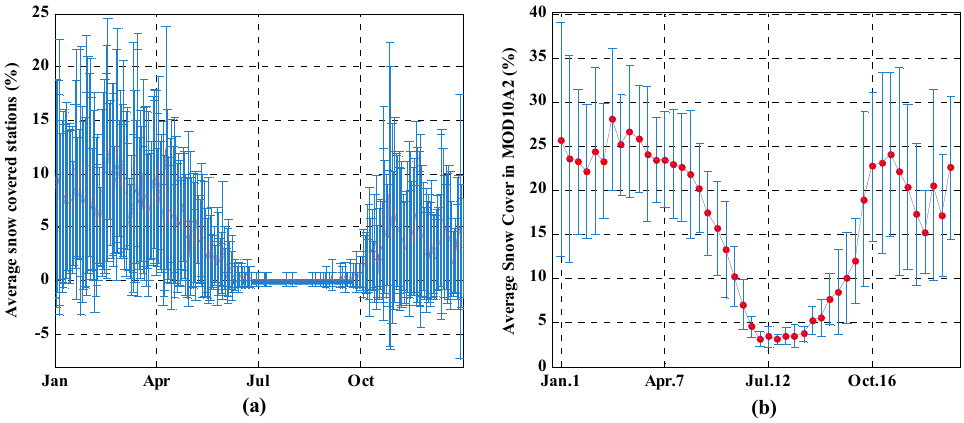
Figure 13. The average annual cycles (red curves) of the percentage of daily snow-covered stations ( a ) and of the MODIS eight-day data ( b ). The vertical blue bars indicate ± one standard deviation.